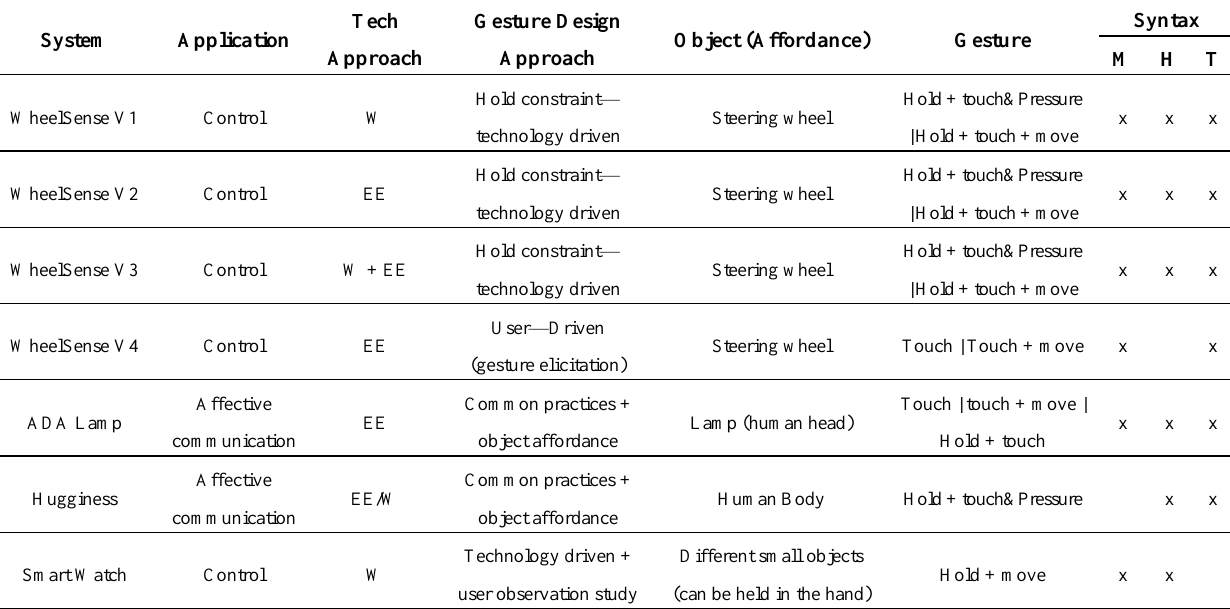
Table 2. TGIF design space explored through the application examples of Section